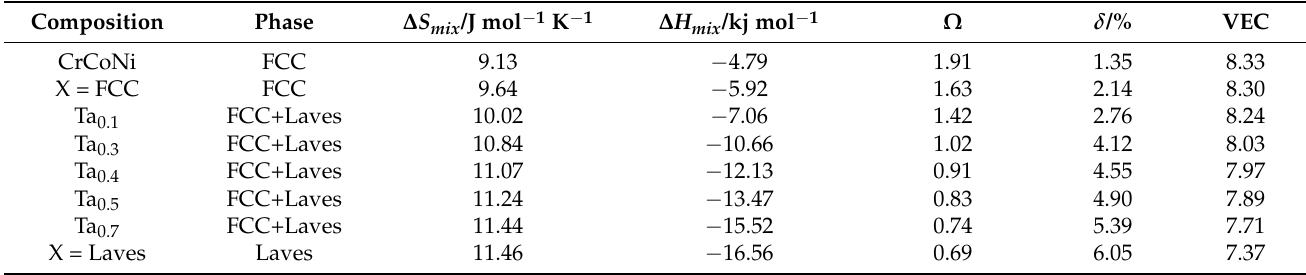
Table 2. Entropy of mixing ( ∆ H mix ), enthalpy of mixing ( ∆ S mix ), Ω , atomic size difference ( δ ), valence electron concentration (VEC) of the CrCoNiTa x alloy